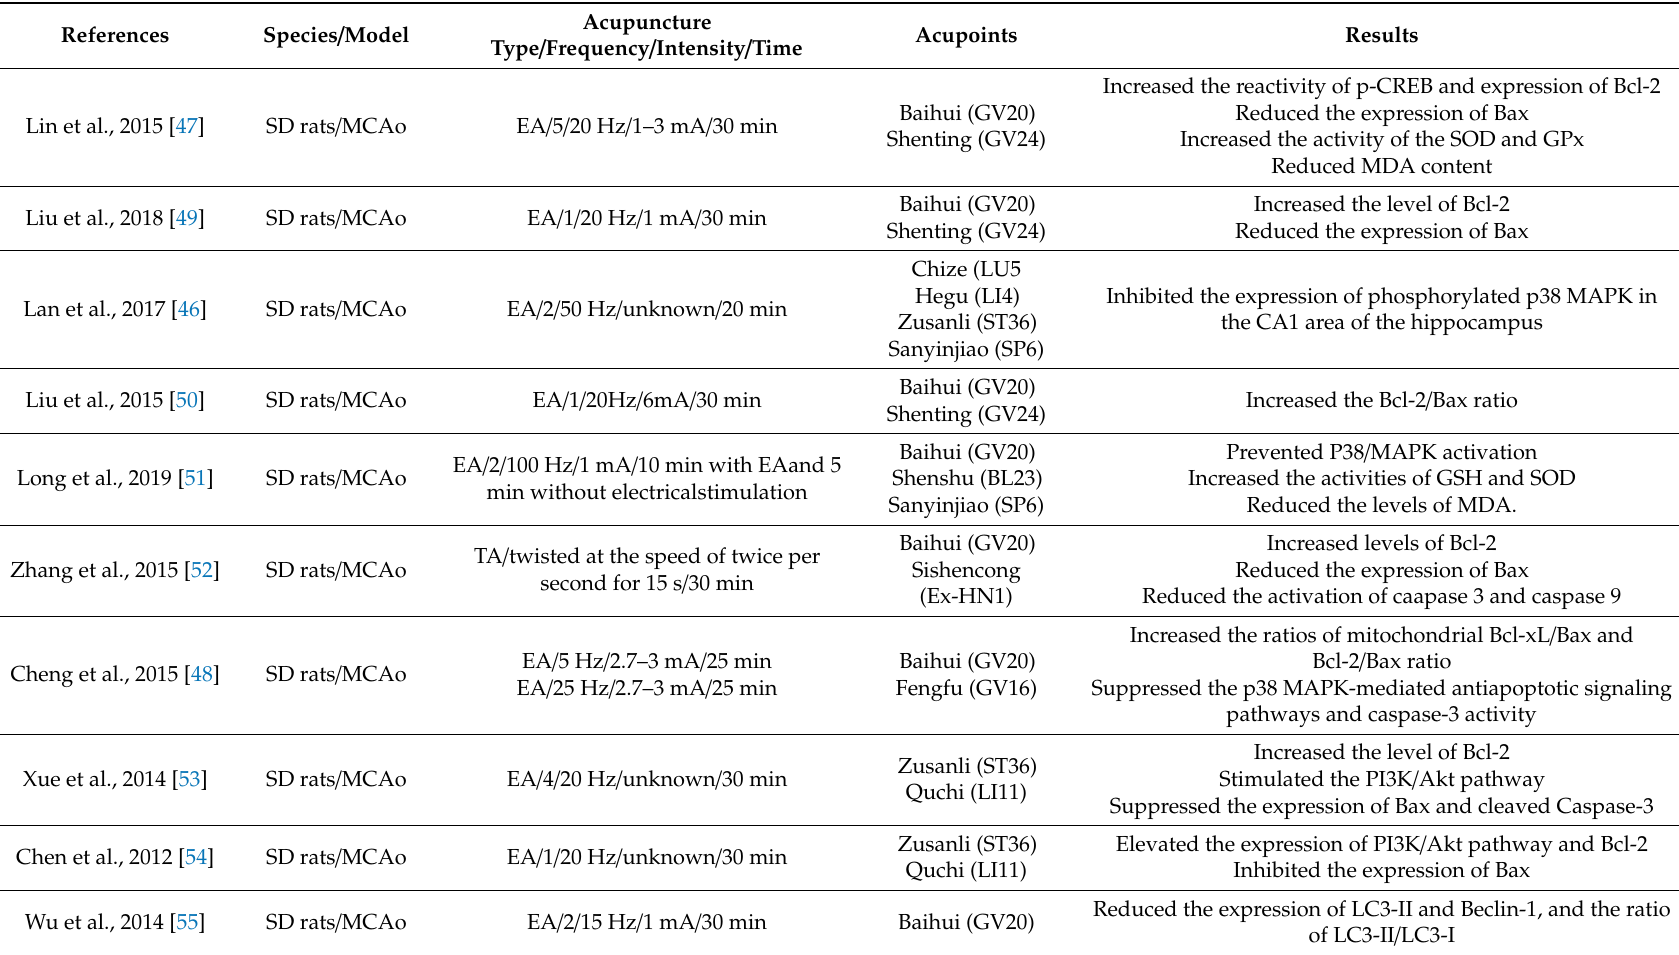
Table 4. Acupuncture inhibits downstream of the ROS pathway to cell apoptosis or